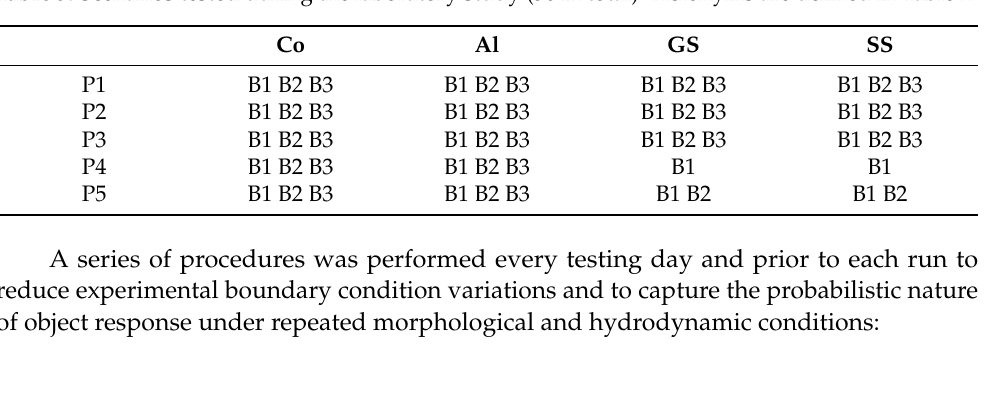
Table 3. Scenarios tested during the laboratory study (56 in total). Acronyms are defined in Table